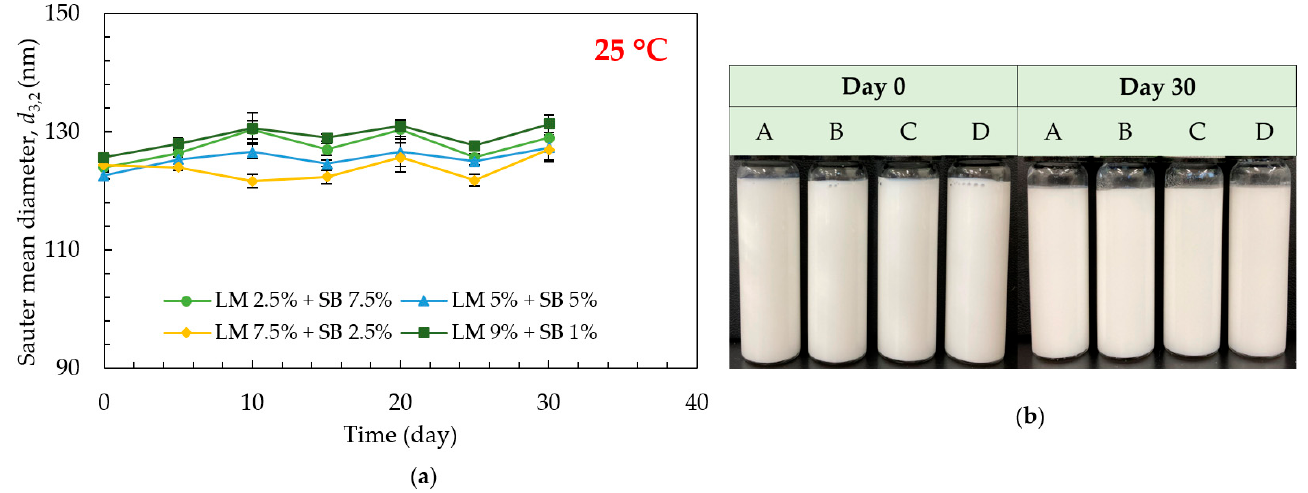
Figure 4. Effect of storage time, temperature, and SB concentration on the physical stability of the emulsions loaded with LM during 30 days of storage at 25 °C. ( a ) Sauter mean diameter ( d 3,2 ) and ( b ) The photos of the emulsions on days 0 and 30 where A: LM 2.5% + SB 7.5%, B: LM 5% + SB 5%, C: LM 7.5% + SB 2.5%, and D: LM 9% + SB 1%.